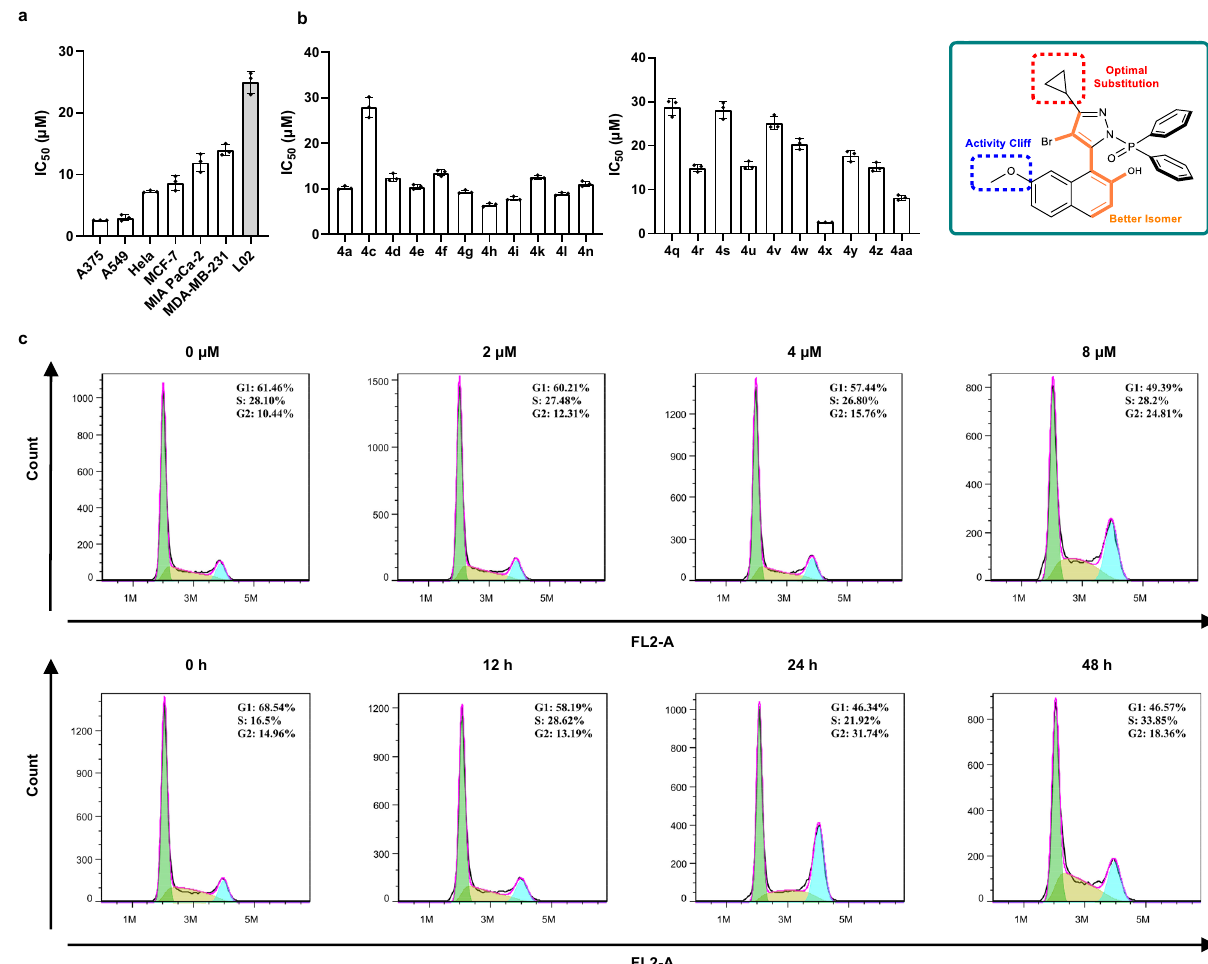
Fig. 5 Pharmacological research on the axially chiral naphthyl-pyrazoles. a The IC 50 values of 4x toward different cell lines. b The IC 50 values of tested azoles toward A375 cells and structure-activity fi ndings. c Compound 4x induced A375 cell cycle arrest both in the dose- and time-dependent (Fig. 7a). The failures indicated that the formation of VQM